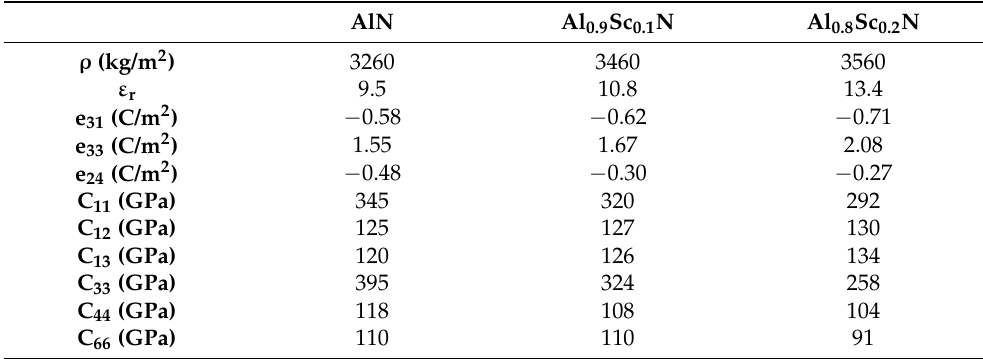
Table 1. Material constants of piezoelectric film used in the